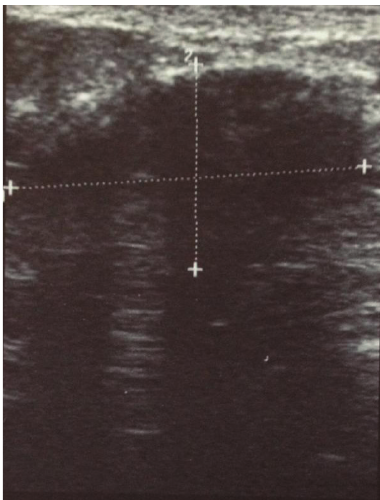
Figure 1: Ultrasonogram showing dense posterior acoustic shadow- ing of the lesion.